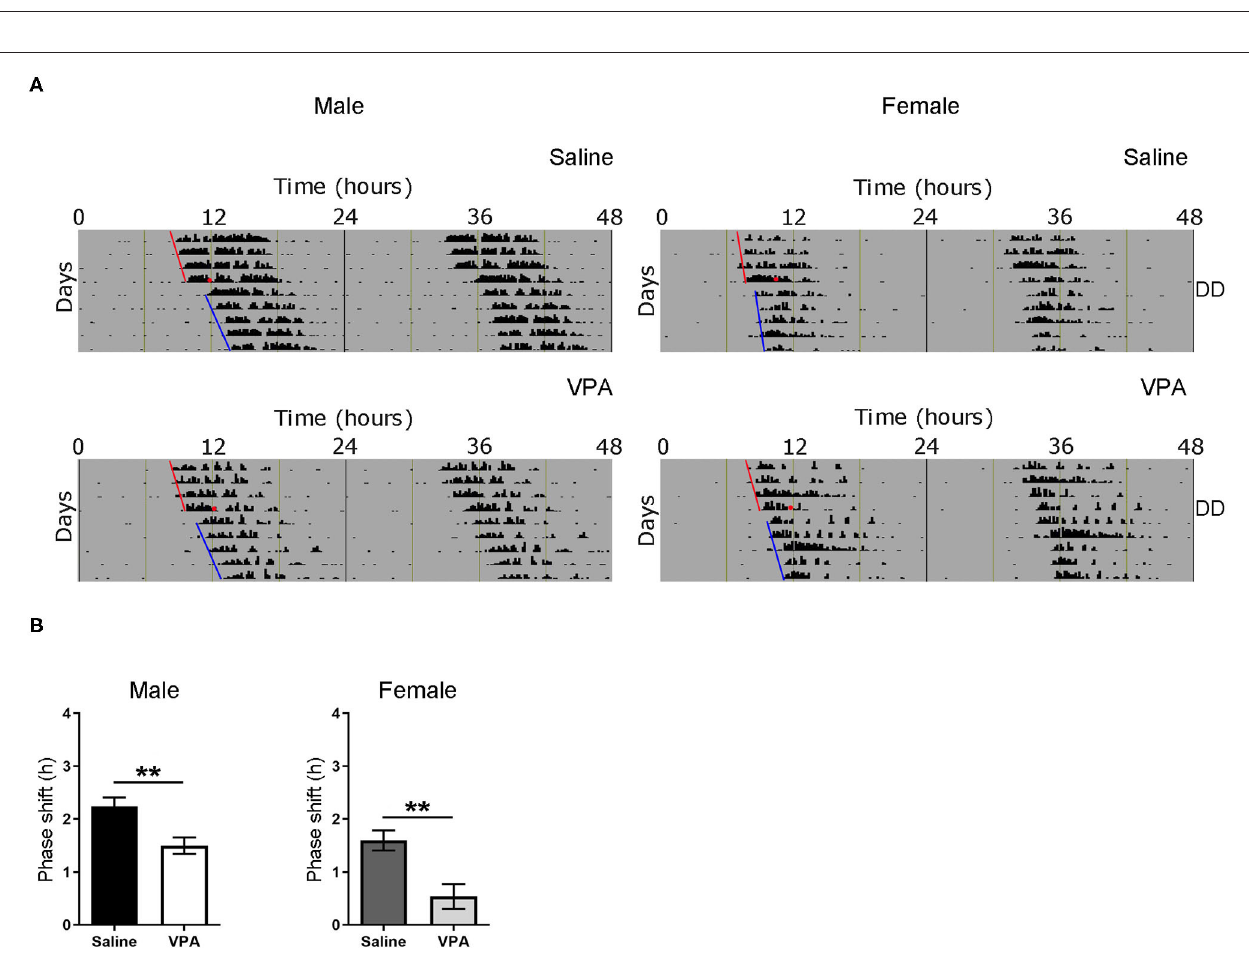
FIGURE 4 | Altered responses to an Aschoff type-1 light pulse in VPA-exposed animals. (A) Representative double-plotted actograms from (left panel) saline-exposed males and VPA-exposed males. Right panels represent double-plotted actograms from saline-exposed females and VPA-exposed females, maintained under DD conditions for 6 days before a 1h light pulse at CT 15 (3h after the onset of wheel-running activity) was elicited (represented by the black circle). The subsequent phase shift in activity can be observed. (B) The averaged phase shift (h) over 5 days, for VPA and saline-exposed males/females. Both VPA-exposed male/female animals demonstrate a lessened phase-shifting response (Males; saline: M = 2.238 ± 0.1688, VPA: M = 1.495 ± 0.1549, p = 0.0043. Females; saline: M = 1.595 ± 0.1900, VPA: M = 0.5351 ± 0.2368, p = 0.0044). Data was analysed using a two-tailed unpaired t -test and are plotted as mean ± SEM. ** p ≤